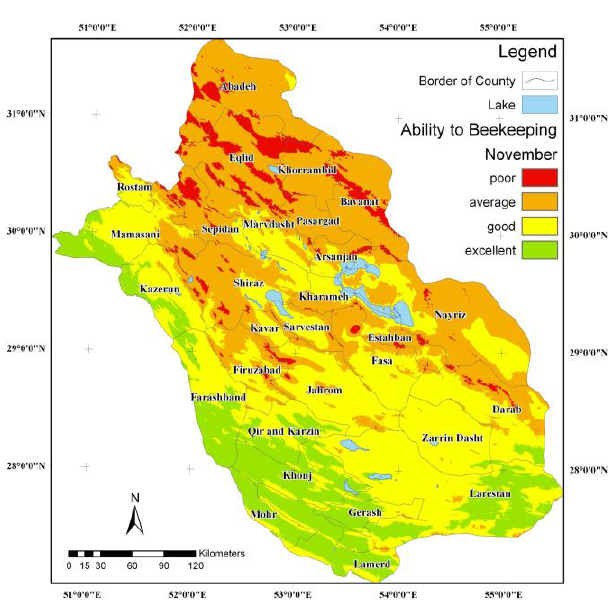
Fig. 7. Suitability of climate conditions for beekeeping in October.